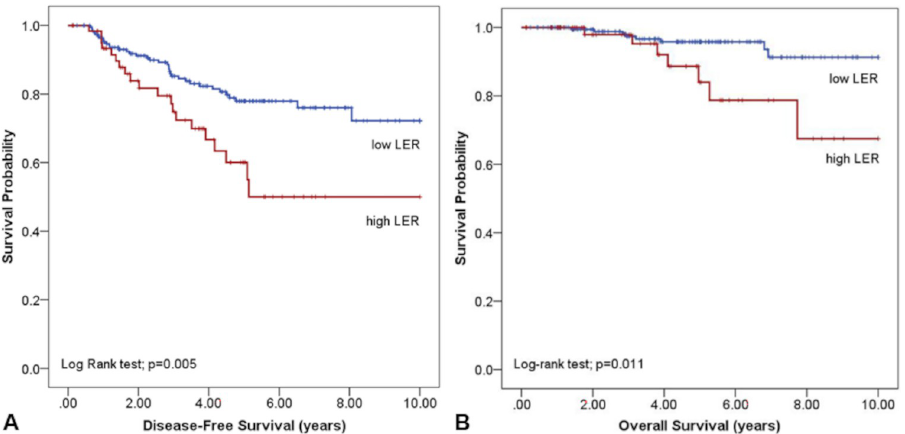
Fig 2. Disease-free survival (A) and overall survival (B) in high LER and low LER group.